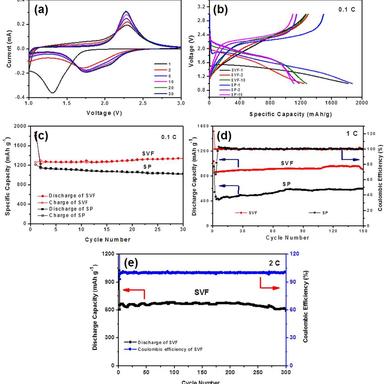
(a) CV profile of SVF cell (scan rate: 0.05 mV s1 , 1.0–3.0 V), (b) charge–discharge profiles of SVF and SP cells at 0.1 C, (c) cycling performance of SVF and SP cells at 0.1 C-rate, (d) cycling performance and Coulombic efficiency of SVF and SP cells at 1 C-rate, and (e) cycling performance and coulombic efficiency of SVF cell at 2 C-rate.